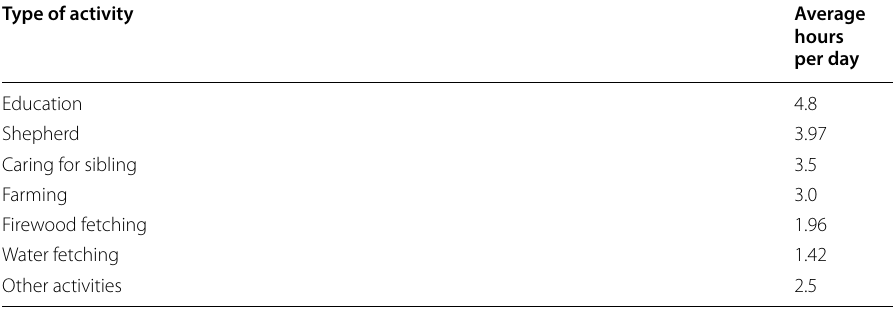
Table 5 Average hours spent by child on different activities. Source: Own Survey, 2015 Type of activity